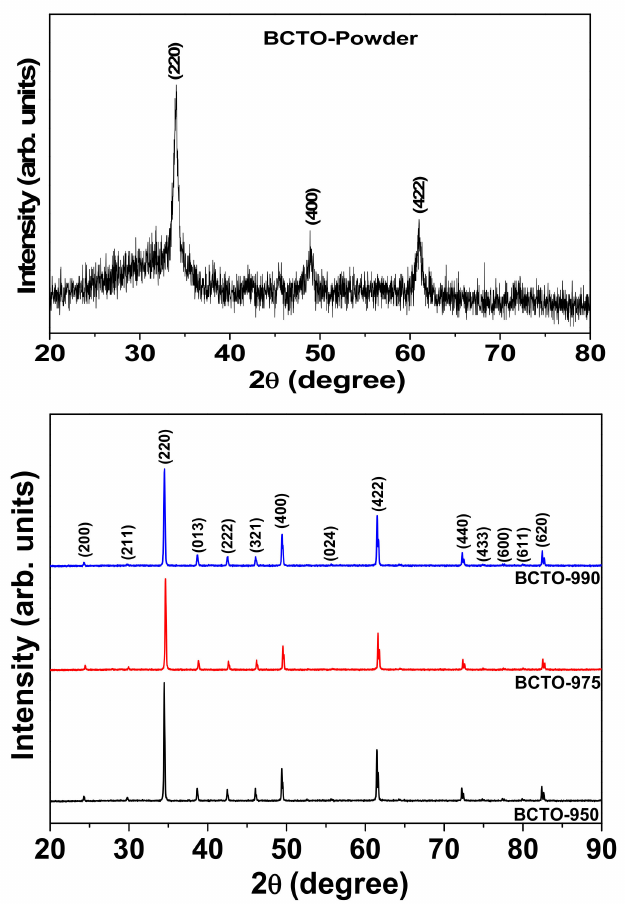
Figure 1. The XRD patterns of the as-synthesized powder ( top ) and the sintered ceramics ( bottom ) of